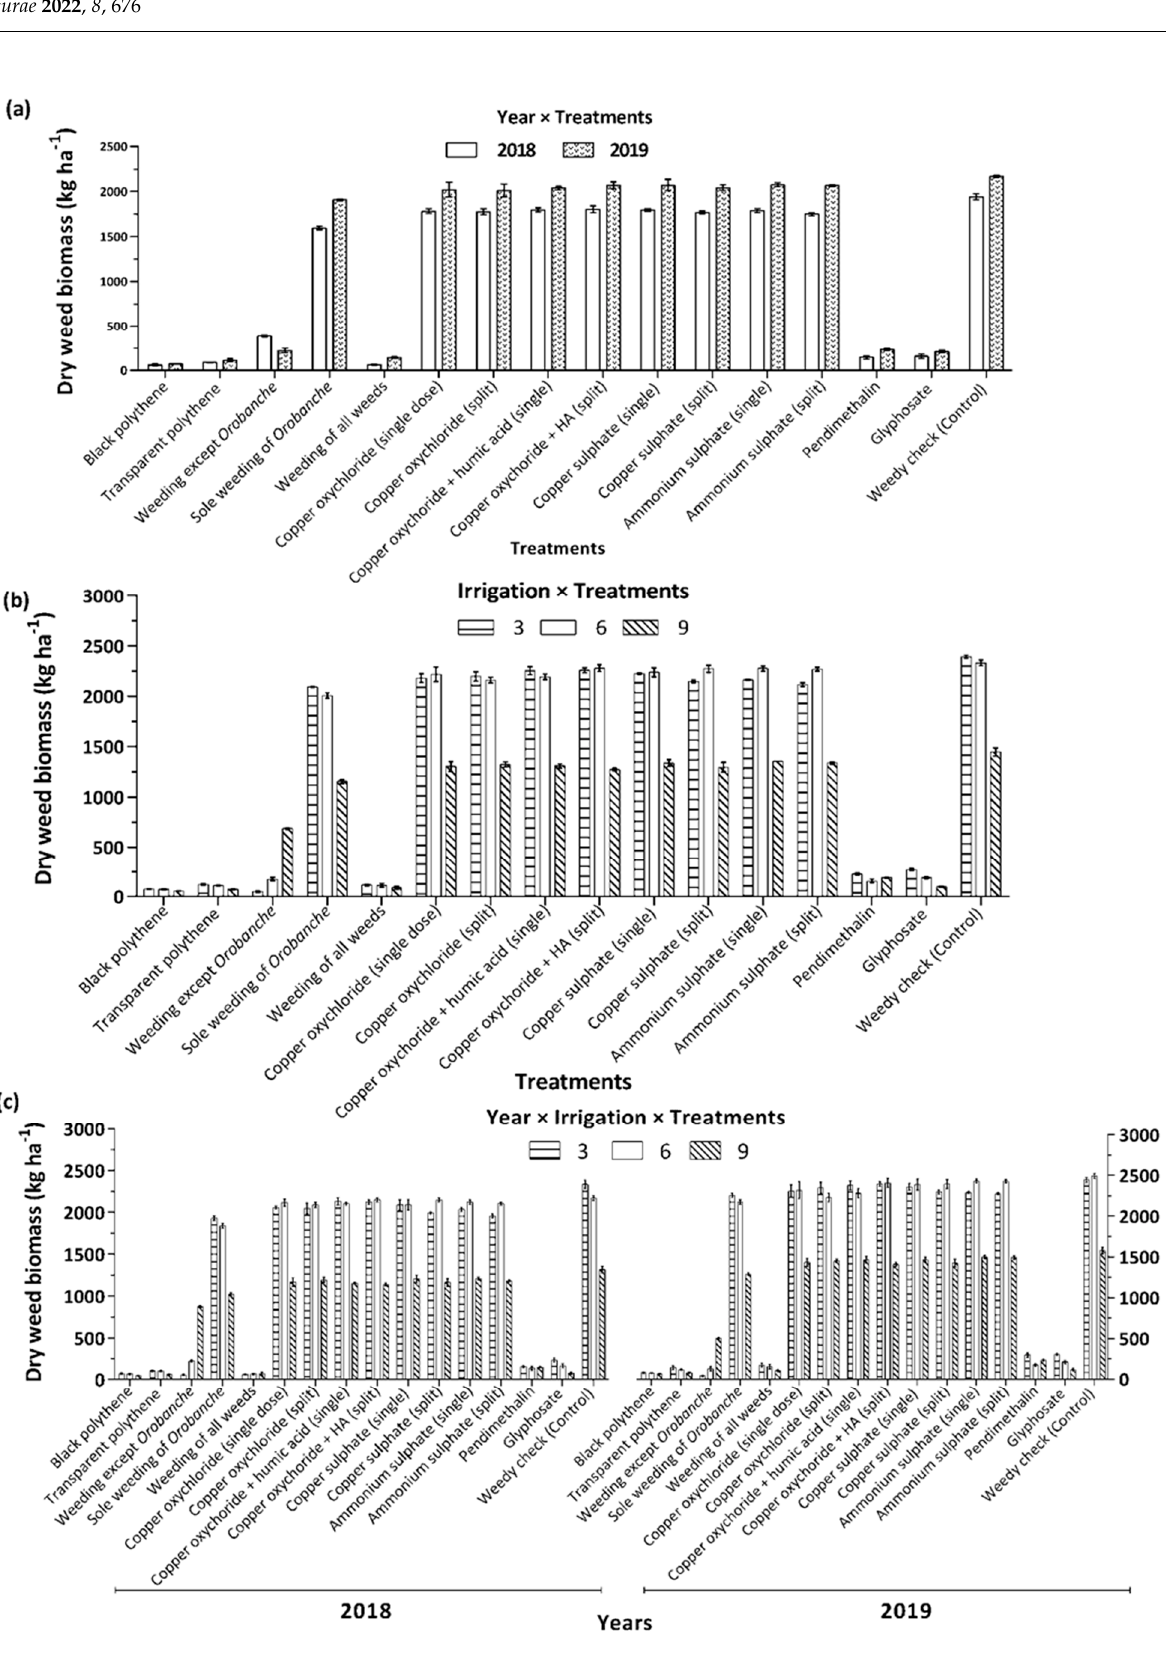
Figure 8. Impact of various interactions on dry weeds biomass (kg ha − 1 ). ( a ) Interaction of year × treatments on dry weed biomass. ( b ) Interaction of irrigation × treatments on dry weed biomass. ( c ) Interaction of year × irrigation × treatments on dry weed biomass.